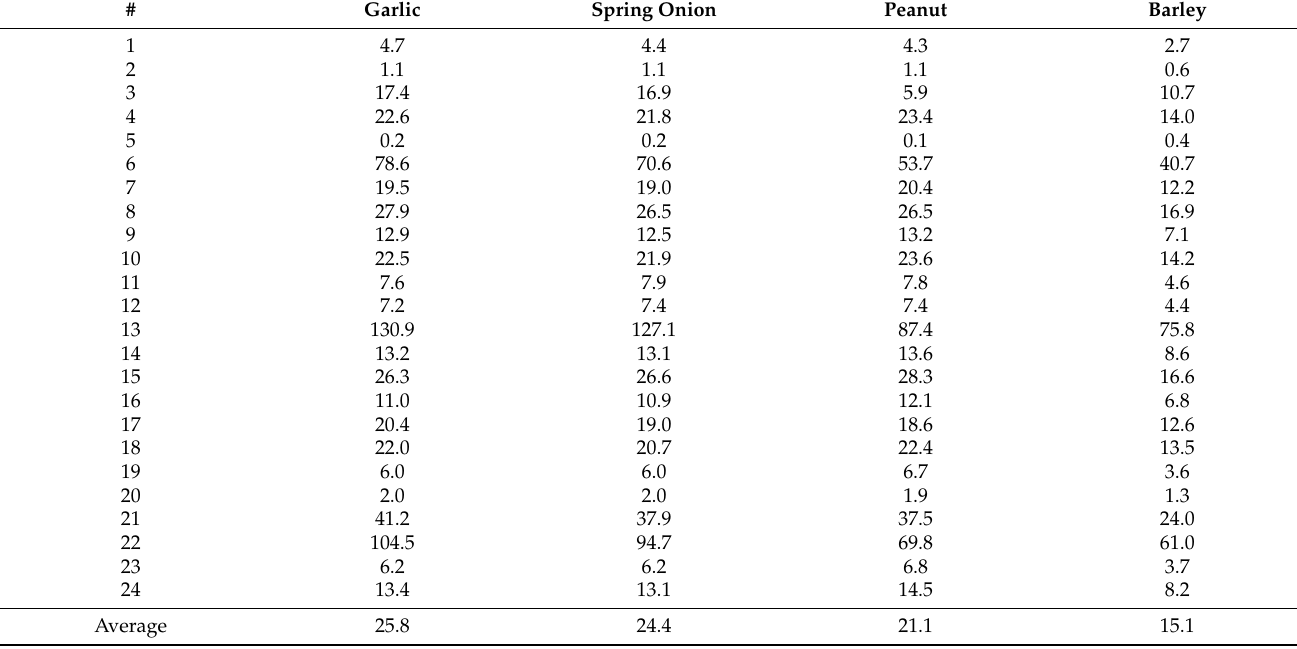
Table 6. Mean irrigation amounts (mm) per crop estimated for the 24 mool-tongs considered in this study. # Garlic Spring Onion Peanut